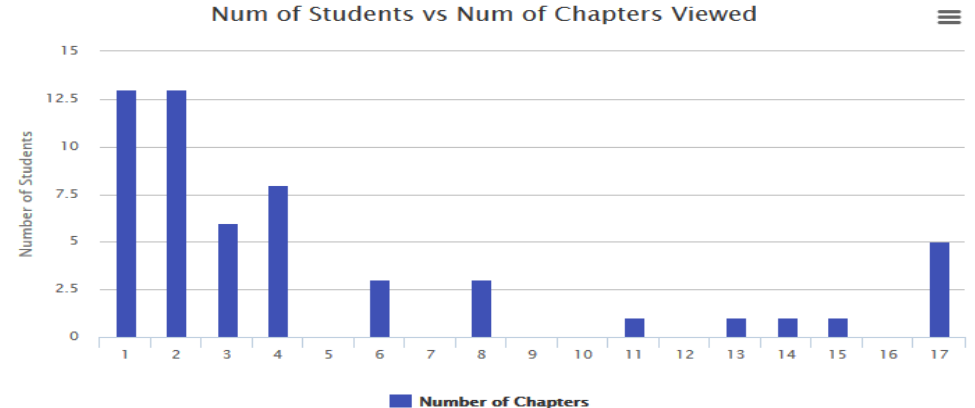
Figure 8. Number of student vs number of chapters viewed .